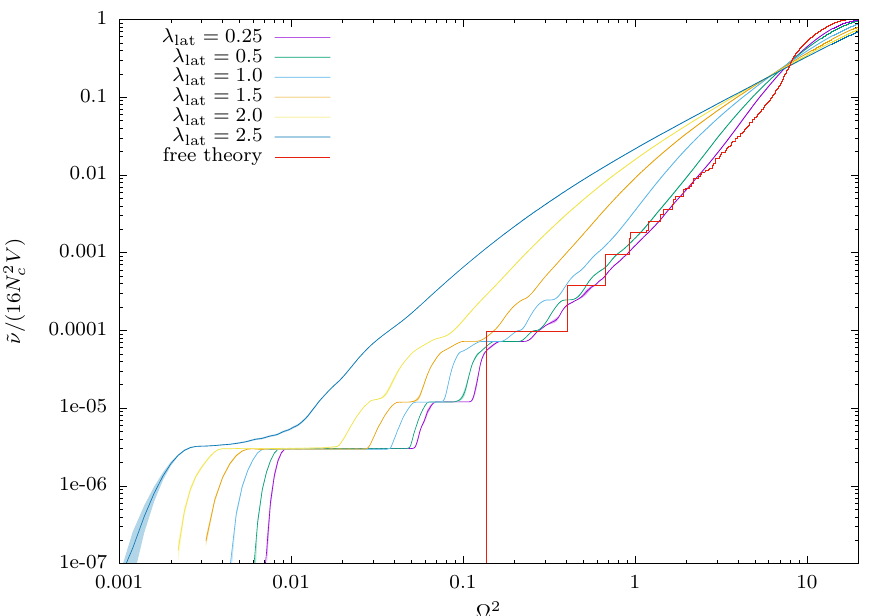
Figure 6. Normalized mode number obtained for gauge group U(2) on 12 4 lattices for all six values of the coupling λ lat , on double-logarithmic axes. We average over all the stochastic Chebyshev measurements specified in table 1 and include small errorbands showing the resulting statistical uncertainty. The analytic result for the free theory is also